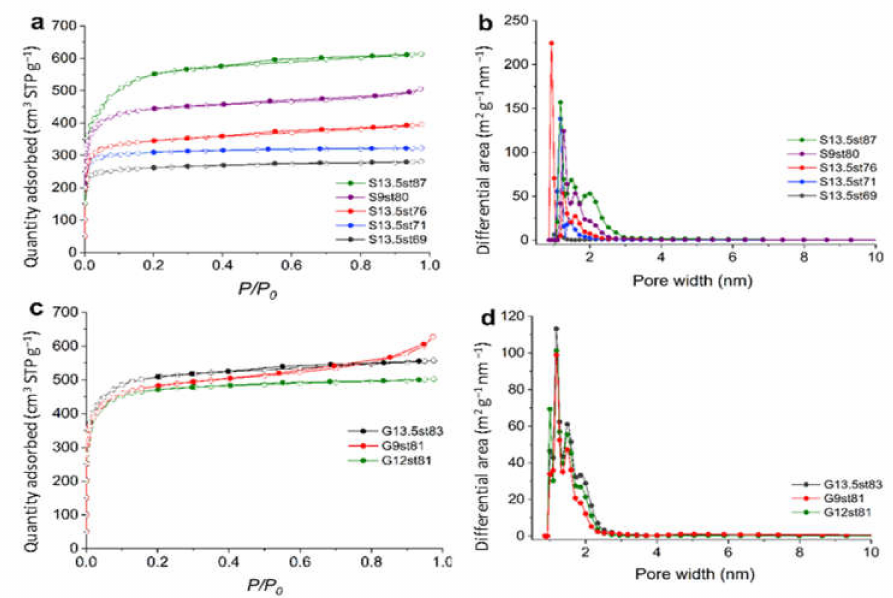
Figure 3. N 2 adsorption–desorption isotherms and the pore size distribution of sisal- ( a , b ) and glucose-derived ( c , d ) activated carbon